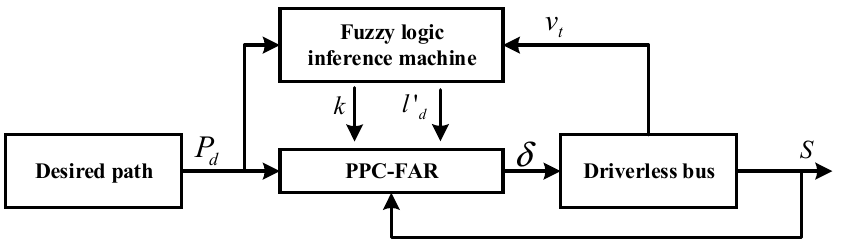
5 of 20 Table 1. Parameters of driverless bus. Symbol